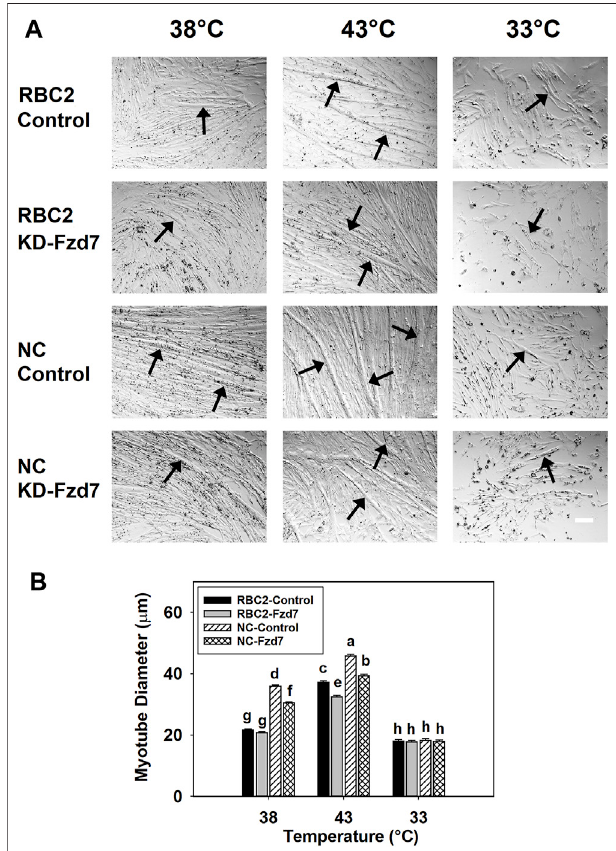
FIGURE 4 | Effect of hot and cold thermal stress and knockdown of frizzled-7 ( Fzd7 ) at the beginning of differentiation on myotube diameter. (A) Randombred Control Line 2 (RBC2) and modern commercial (NC) line SCs proliferated normally at 38 ° C,43 ° C,or33 ° Cand transfected witheithera negative control siRNA (Control) or a siRNA targeting Fzd7 (KD-Fzd7) at 72 h of proliferation, and photomicrographs were captured at 48 h of differentiation. (B) Diameterofmyotubes ineachtreatmentgroup.Each graph bar represents a mean diameter of the myotubes, and each error bar represents a standard error of the mean. Mean values with different letters are signi fi cantly different ( p ≤ 0.05). Black arrows highlight representative myotubes. Scale bar (White) = 100 μ